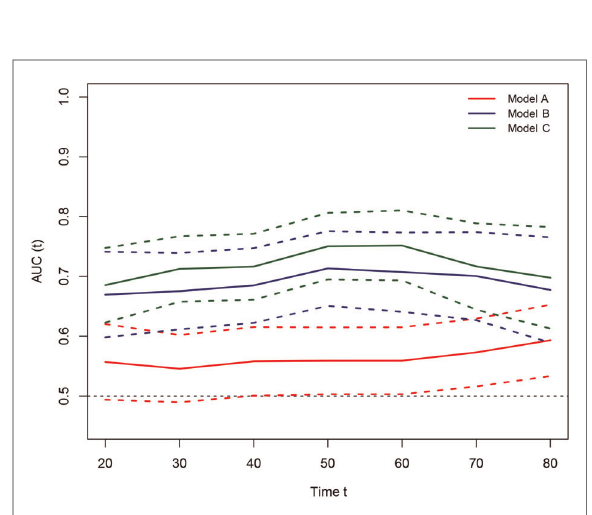
FIGURE 6 Time-dependent receiver-operating characteristic (ROC) curves for the pTNM, non PNI-nomogram, and nomogram model for the prediction of overall survival. The horizontal axis represents the year after surgery, and the vertical axis represents the estimated area under the ROC curve for survival at the time of interest. Red, blue, and green solid lines represent the estimated AUCs of the pTNM, no PNI-nomogram, and nomogram model; and broken lines represent the 95% con fi dence intervals of each AUC. [Model ( A ): the pTNM model; Model ( B ): the non PNI-nomogram model; Model ( C ): the nomogram model]. AUC, area under the curve; PNI, prognostic nutrition index; pTNM, pathological tumor-node-